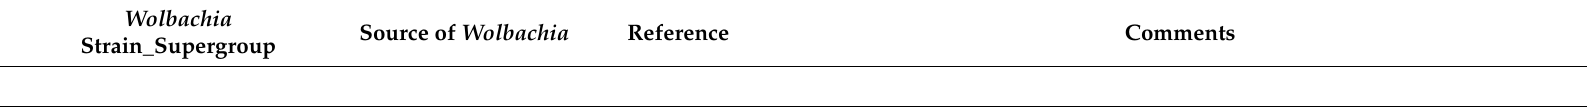
Table 1. Cell lines in which Wolbachia strains have been